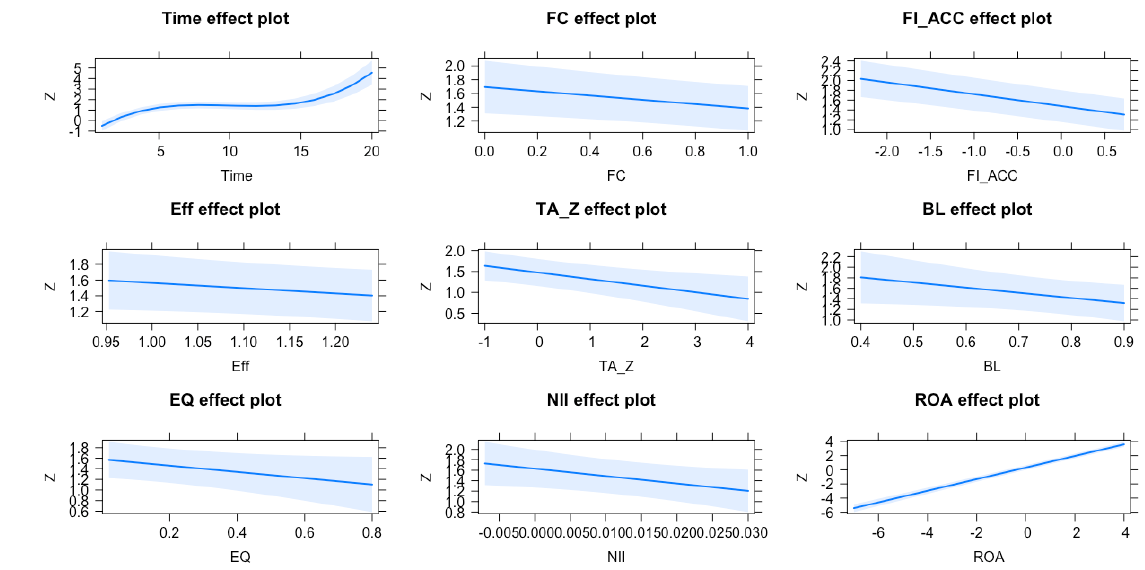
Figure 5. Significant factor effect plots for all banks.